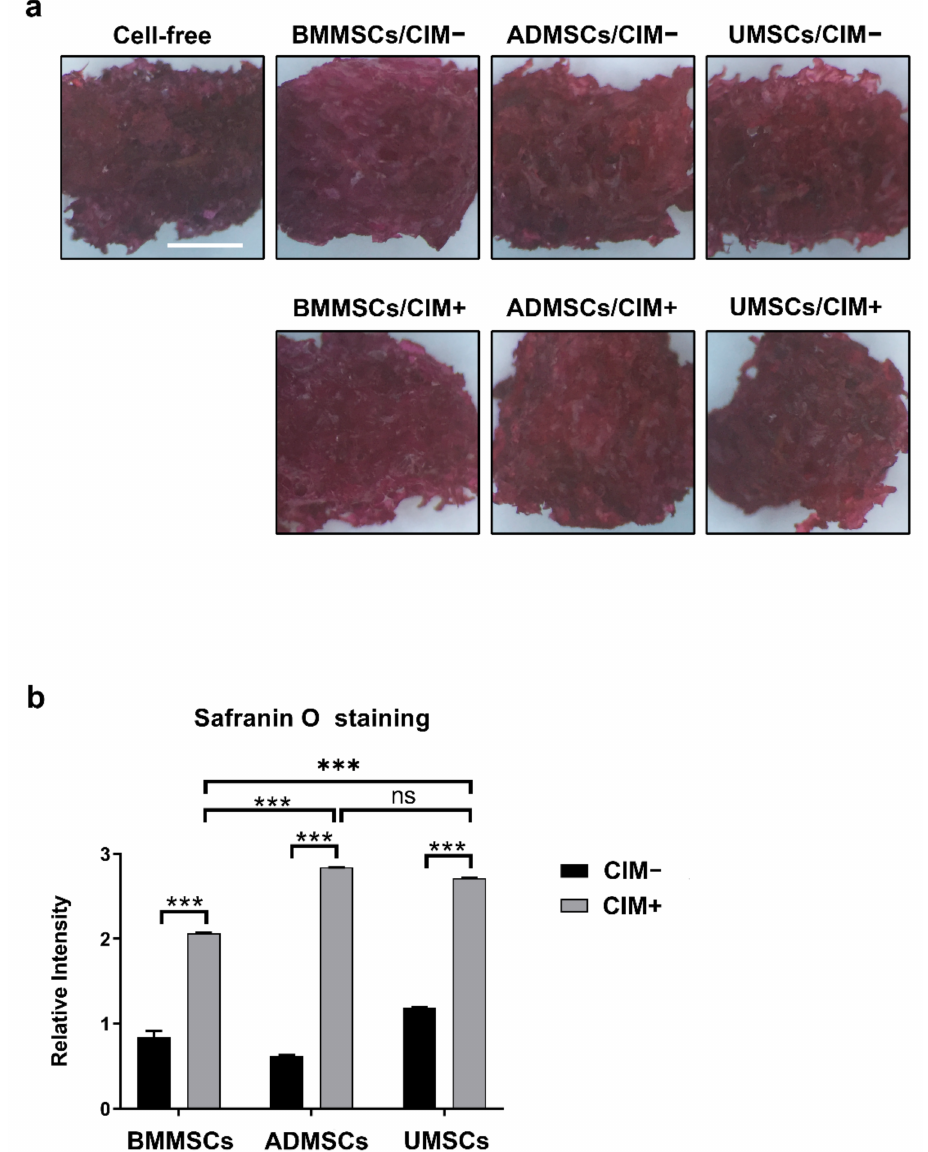
Figure 6. Quantification of proteoglycan on hDCB blocks with hMSCs using Safranin O staining. The hMSCs were seeded on hDCB blocks, and their chondrogenic ability was analyzed through treatment of hMSCs with or without chondrogenic differentiation medium (CIM+ and CIM − , respectively) on day 21. ( a ) The production of cartilage ECM on cell-seeded hDCB blocks after chondroinduction was assessed using Safranin O staining. Scale bars are 1 mm. ( b ) Results of Safranin O staining were normalized to cell-free hDCB blocks. A one-way ANOVA with Turkey’s post hoc test was used to examine the differences between experimental groups. Statistical significance is represented as *** p < 0.001, and not significant